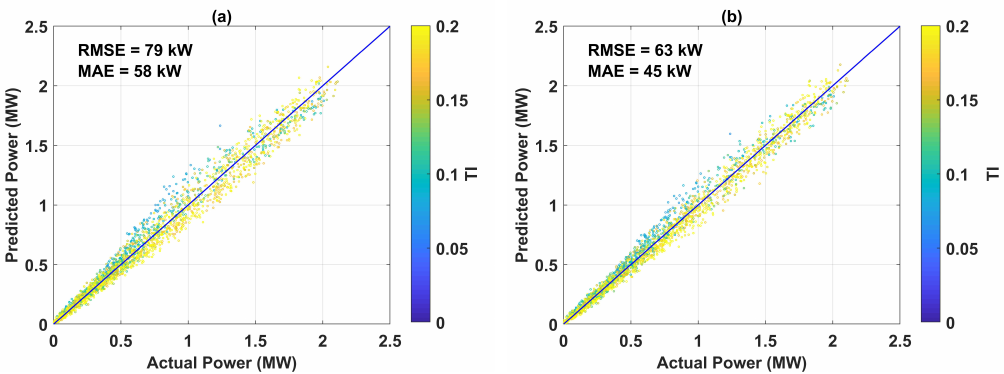
Figure 18. Performance of: ( a ) induction curve using approximated values of turbulent fluxes, and ( b ) double induction curve using approximated values of turbulent fluxes, for predicting power generation of the wind